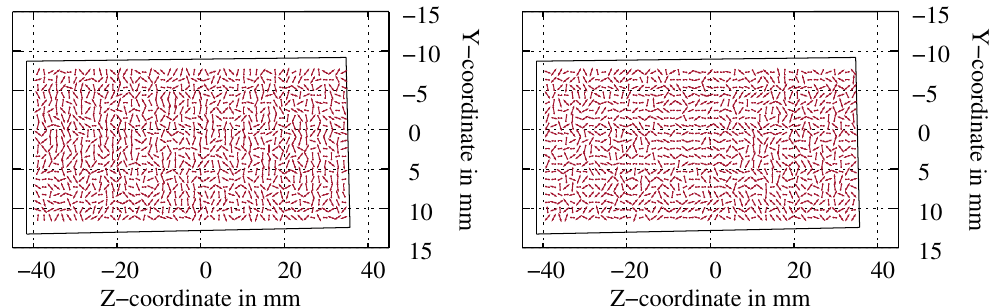
Figure 16. Distribution of principal strain directions associated to the maximum principal strain. The bounding box shows the projected region of the DIC-data: ( left ) 9 px facet size, ( right ) 19 px facet